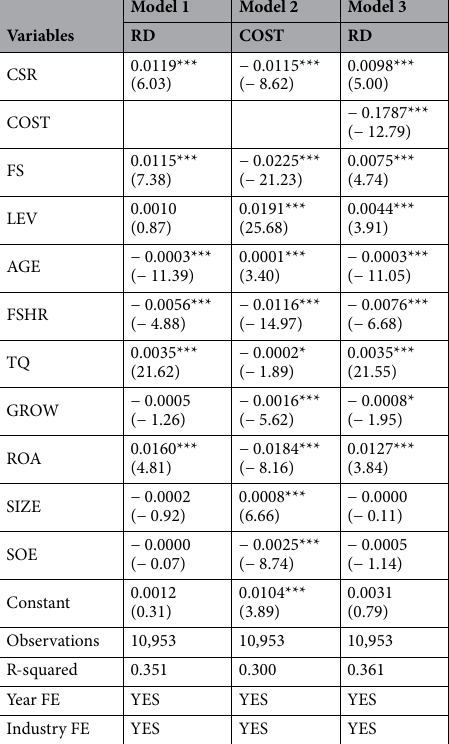
Table 4. Corporate social responsibility, debt financing cost and enterprise innovation. ***, ** and * respectively indicate that the parameter estimation is significant at the levels of 0.01, 0.05 and 0.1. The “t” value is in